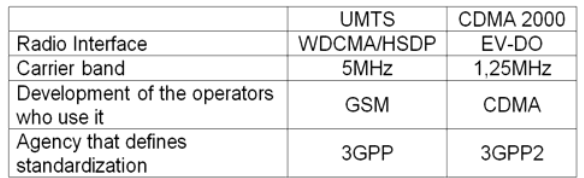
TABLE I. S TANDARDS FOR A 3G CELLULAR